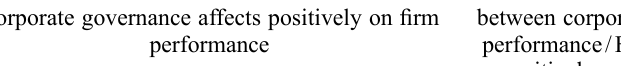
Table 1. Studies evaluating correlation between corporate governance and firm performance There is no positive relationship Corporate governance affects positively on firm between corporate governance, and firm performance performance / Firm performance affects positively on corporate